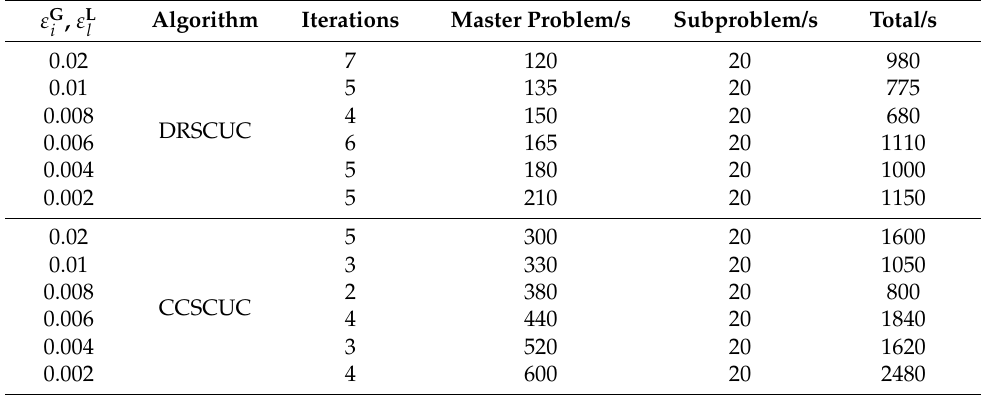
Table 4. Algorithm calculation efficiency